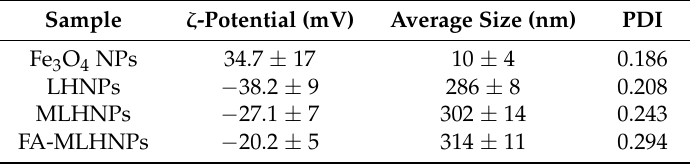
Figure 1. Schematic illustration of layer-by-layer self-assembly of folic-magnetic-functionalized lignin hollow nanoparticles (FA-MLHNPs). Table 1. Average size, polydispersity (PDI) and ζ -potential of four types NPs.